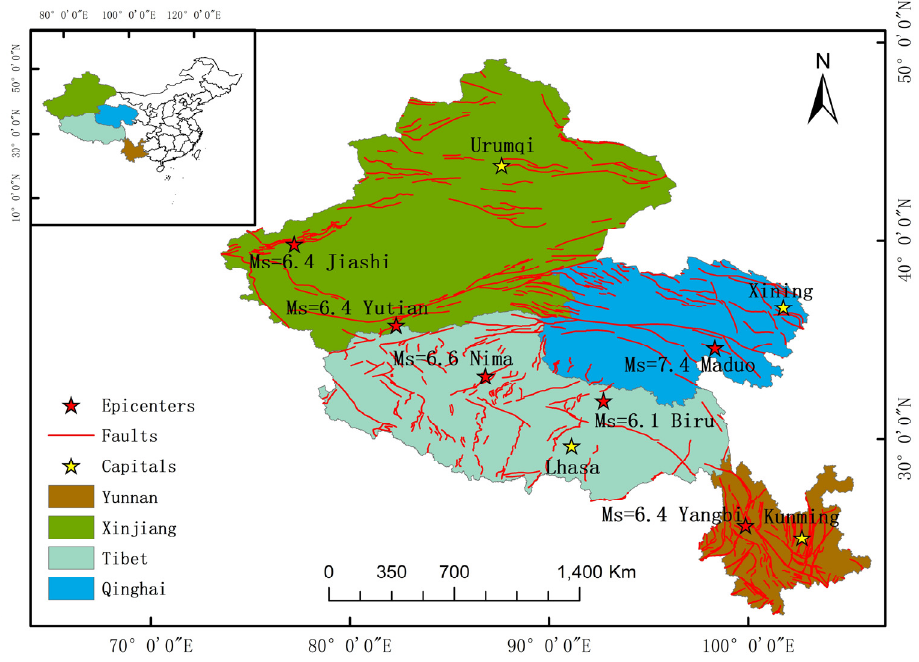
Figure 1. Geographical location of the six earthquakes (Ms > 6.0) in China during 2020–2021. The red stars, red lines, and yellow stars represent the epicenters, faults, and capitals, respectively. Table 1. Essential characteristics of the studied earthquakes.